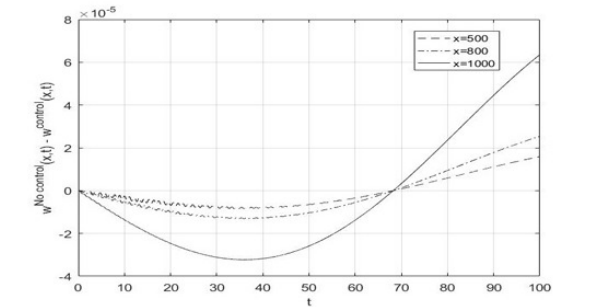
Figure 2. Difference between the riser displacement with/without control, at x = 500 , 800 , 1000 m